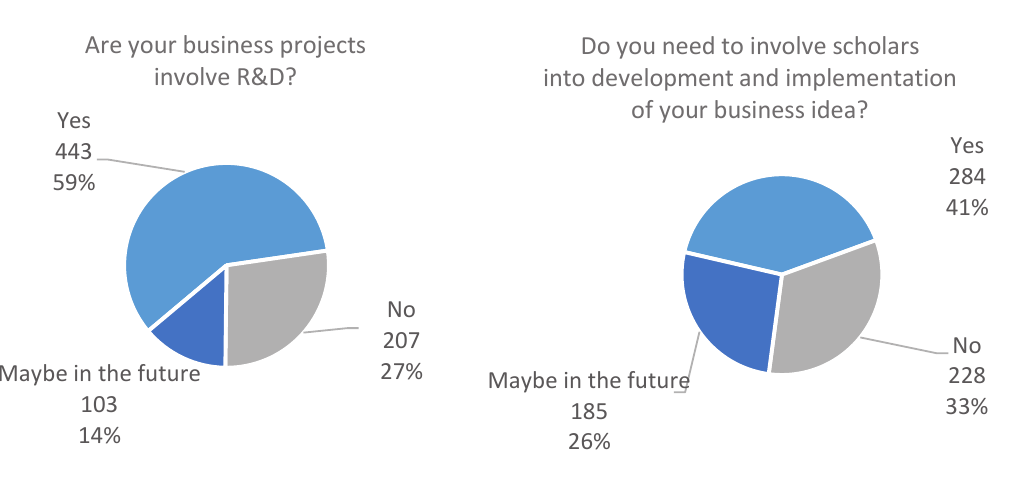
Figure 10. The structure of the respondents’ answers to questions that determine the business’s need to collaborate with